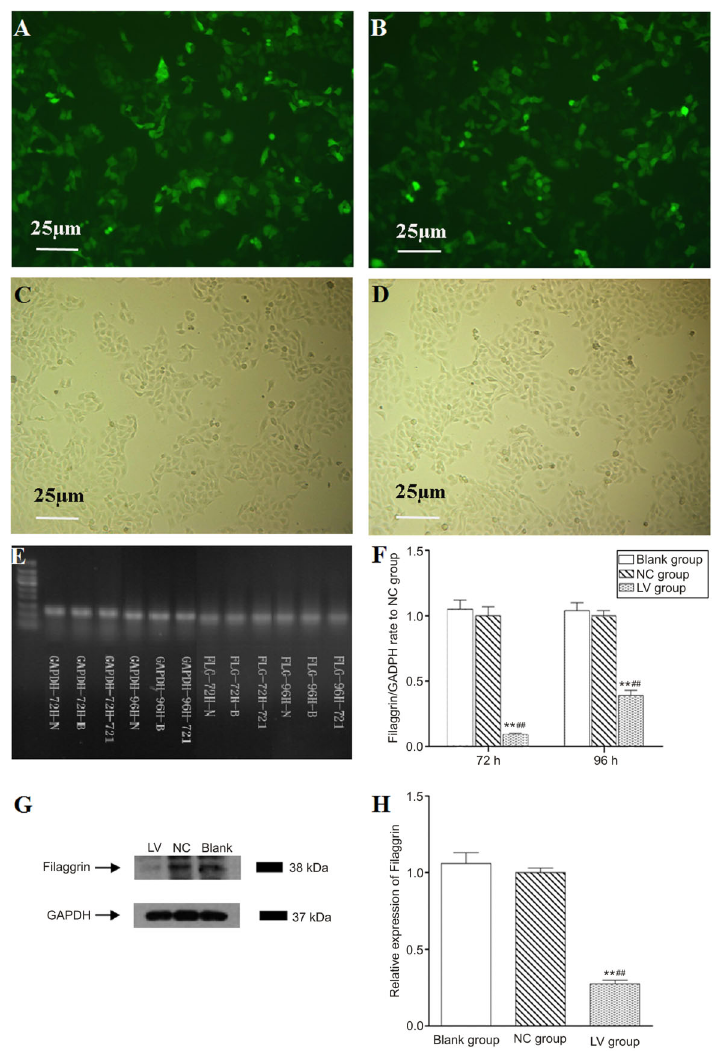
Figure 1. Filaggrin silencing in normal human epidermal keratinocytes (NHEKs). Cell sorting was carried out by selecting cells expressing the green fluorescent protein (GFP) marker. NHEKs after 72 and 96 h infection were analyzed by PCR and Western blotting analysis, respectively. A and B , Photographs of NHEKs in the LV (filaggrin-silenced cells) and NC (shRNA control cells) groups taken after cell sorting under a fluorescent microscope (100 6 ). C and D